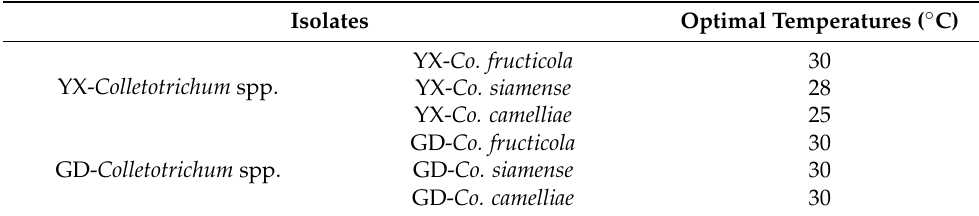
GD- Colletotrichum